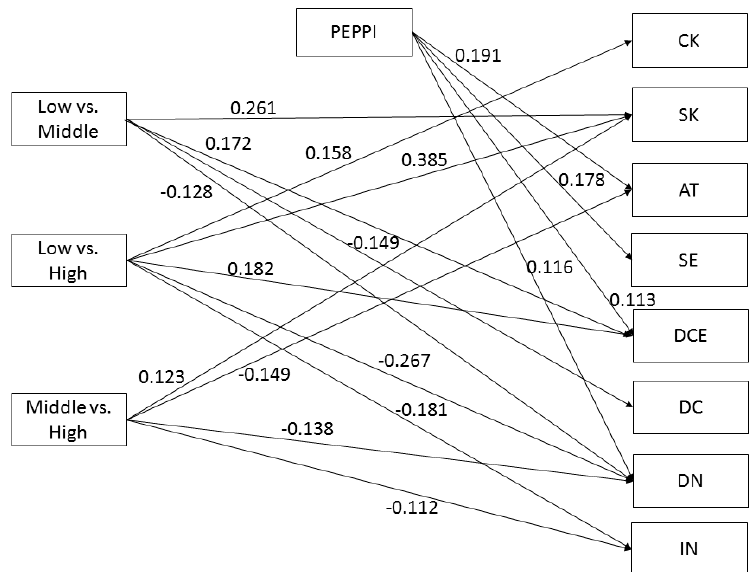
Figure 5. Communication as mediator. Note: CK = CRC knowledge; SK = screening knowledge; AT = attitude; SE = self-efficacy; DCE = decisional certainty; DC = decisional conflict; DN = descriptive norm; IN = injunctive norm. Non-significant paths are not shown.